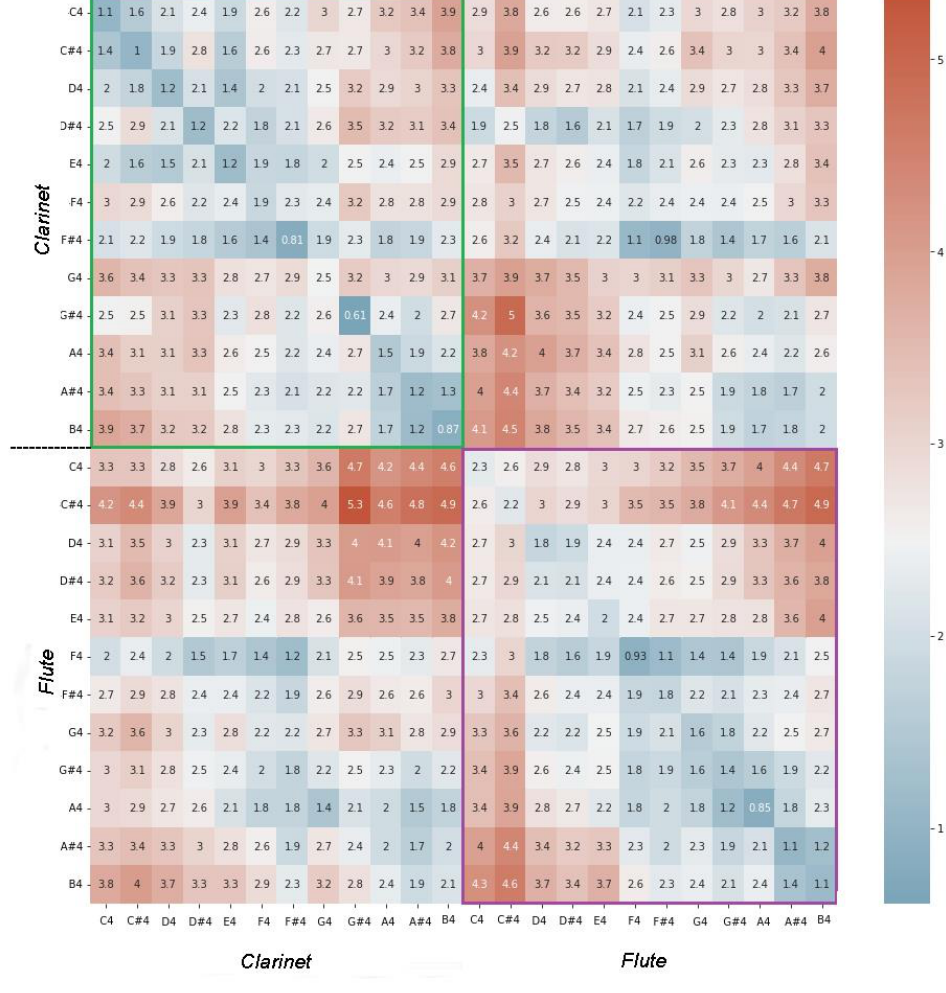
Figure 2. Patterned distance between musical sounds for Clarinet and Flute in mezzo-forte for the 4 4 ta octave, reference sounds in the data ta octave, reference sounds in the data set.